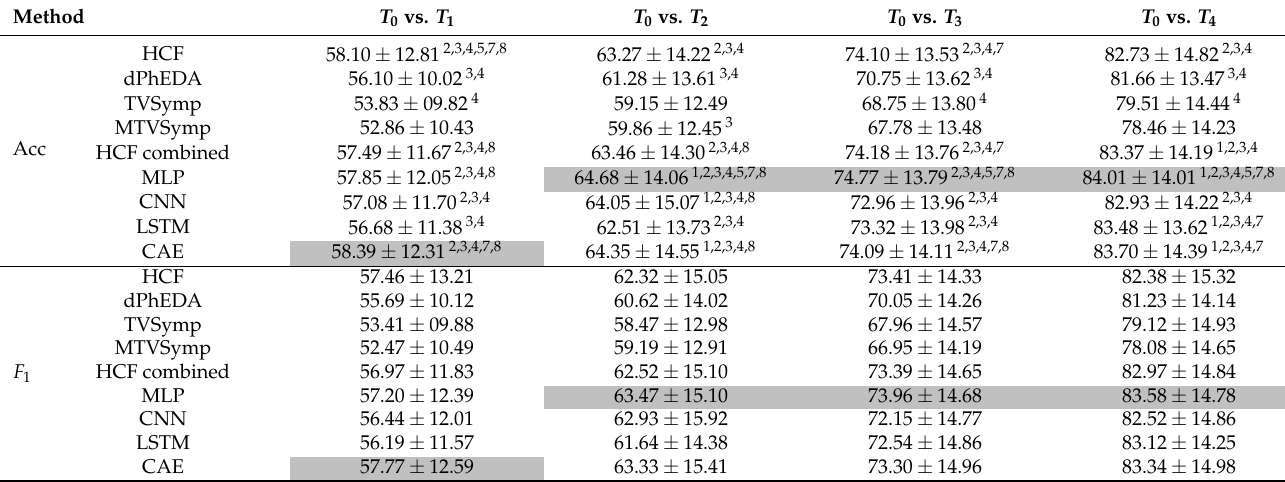
Table 6. 5 × Leave-one-subject-out (LOSO) average performance using the EDA sensor of the BVDB for several feature extraction methods in combination with a Random Forest. Performance metrics are given as average accuracy (upper) and F 1 score (lower half) ± average standard deviation of each individual LOSO run. The best performing approach is highlighted in grey. Moreover, a paired student’s t -test with a significance level of 5% was performed to check the significance in differences between the accuracies obtained by each pair of approaches for each classification problem. 1,2,3,4,5,6,7,8,9 indicate a significant improvement compared to the HCF, dPhEDA, TVSymp, MTVSymp, “HCF combined”, MLP, CNN, LSTM, and CAE approaches, respectively.